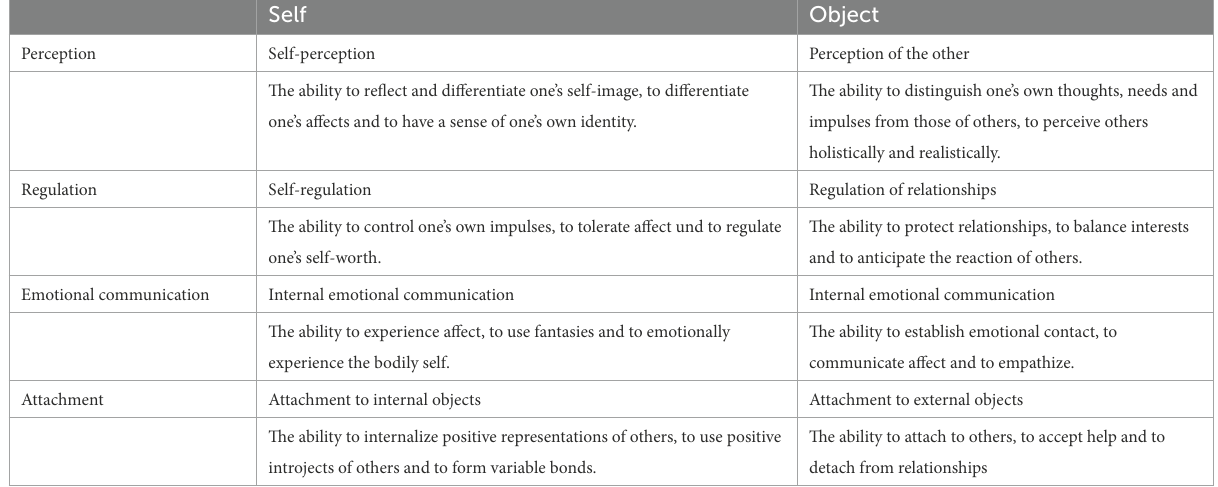
TABLE 1 Definition of the dimensions of structural